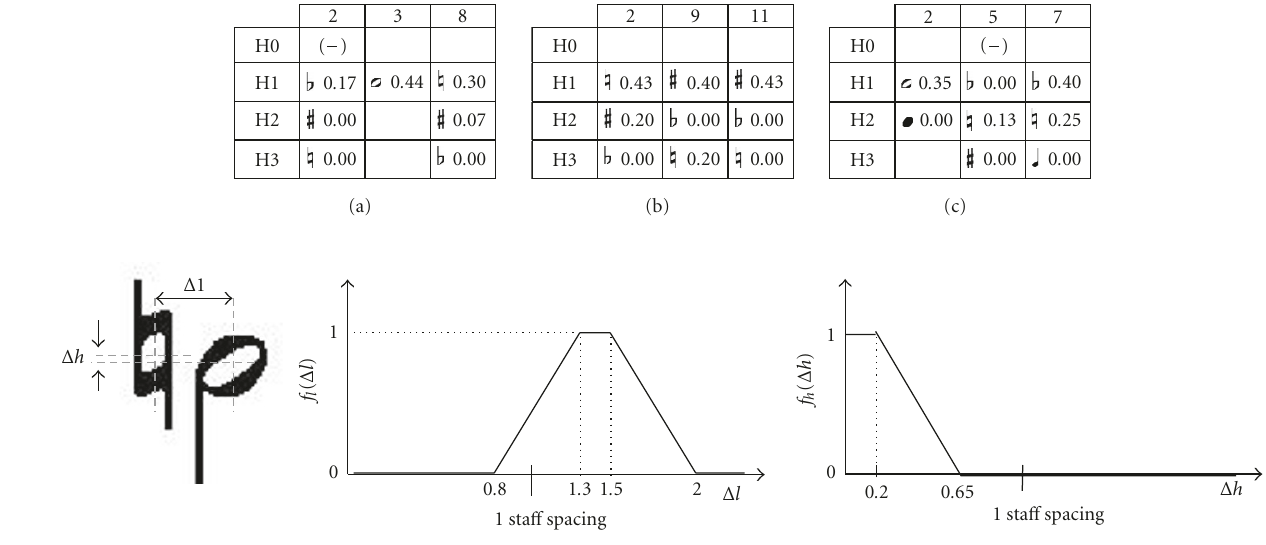
Figure 14: Accidental/note graphical